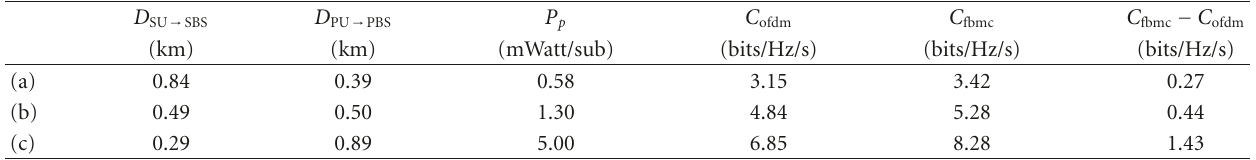
Table 5: Three typical channel